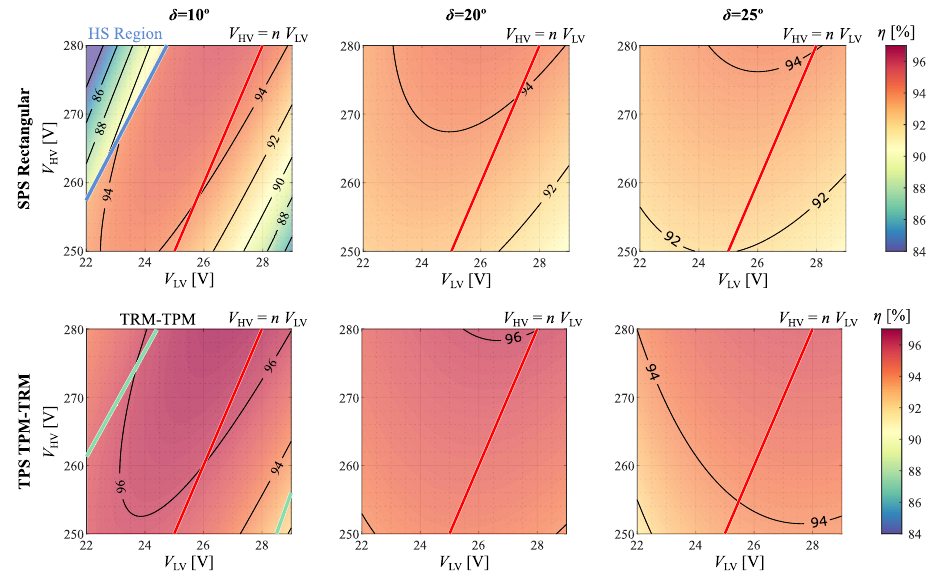
Figure 6. Efficiency map of the DAB converter at P = 10kW when working with SPS rectangular ( top ) and combined TPS TPM and TRM ( bottom ) modulations for different δ lim : 10 ◦ , 20 ◦ and 25 ◦